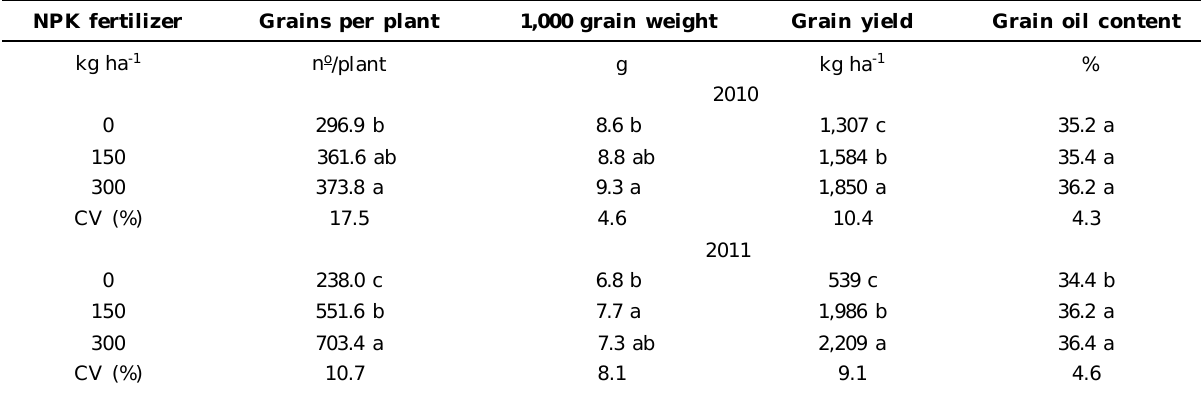
Values followed by different letters, in the column, were significantly different by the the LSD test (p